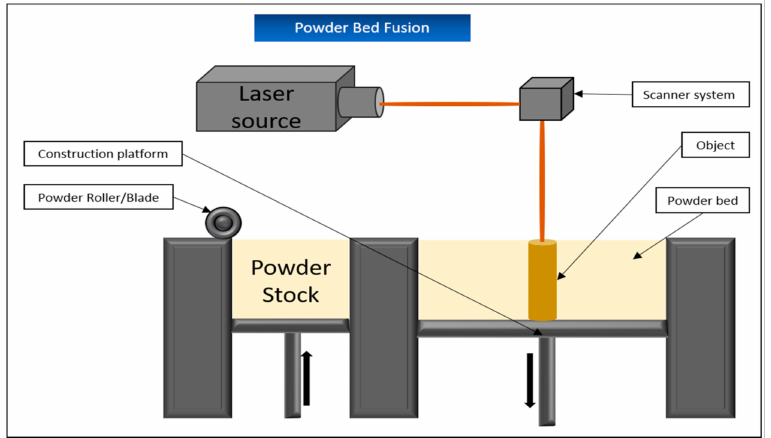
Figure 13. Schematic representation of the powder bed fusion. The continuously applied layers of the material powder are hardened at the required points using a laser